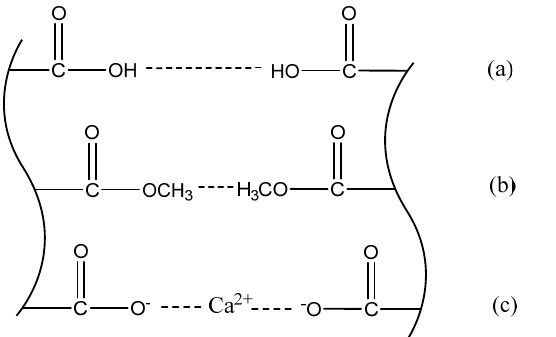
Figure 3. Eggshell model: ( a ) Hydrogen bond, ( b ) Water separating force between methoxy groups and ( c ) Calcium bridge.